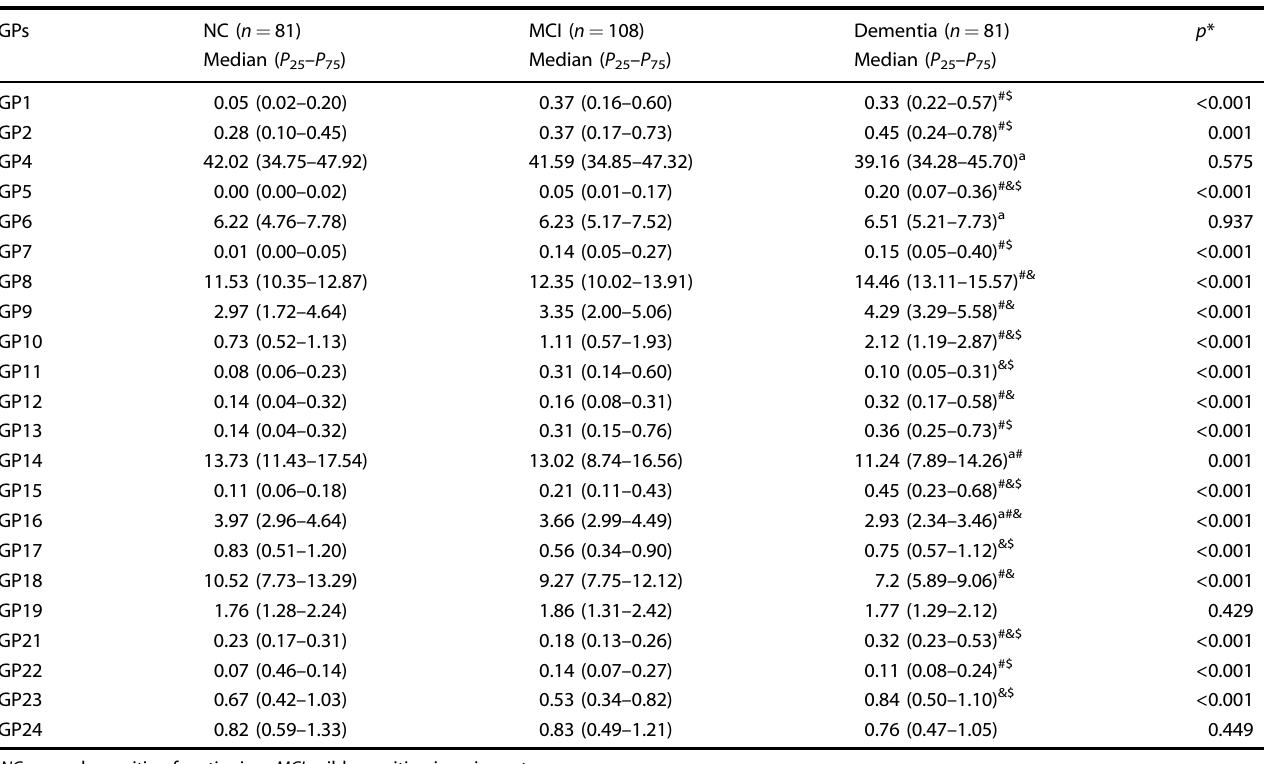
Table 2. The levles of initial glycans from NC, MCI, and dementia